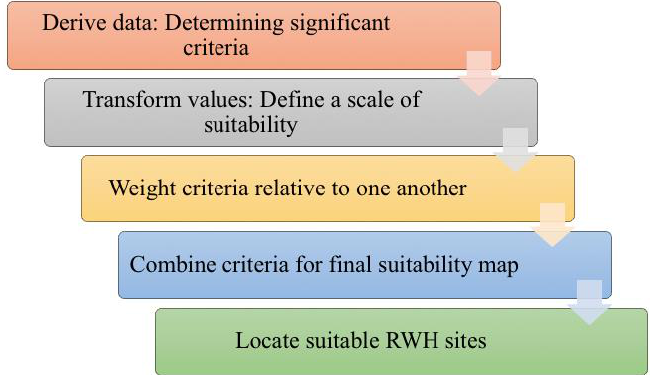
Figure 3. Main steps used in RWH site suitability data processing.